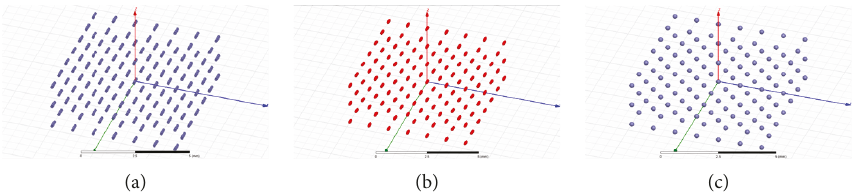
Figure 5: Ensembles of (a) hexagonal columns, (b) ellipsoids, and (c) spheres simulated by HFSS software.